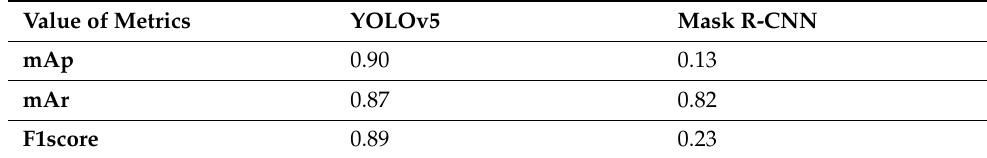
Table 1. Comparison table of YOLOv5 and Mask R-CNN.